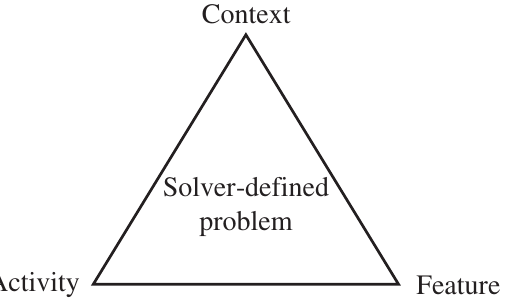
FIG. 1. Emergent framework describing problems from the solver ’ s